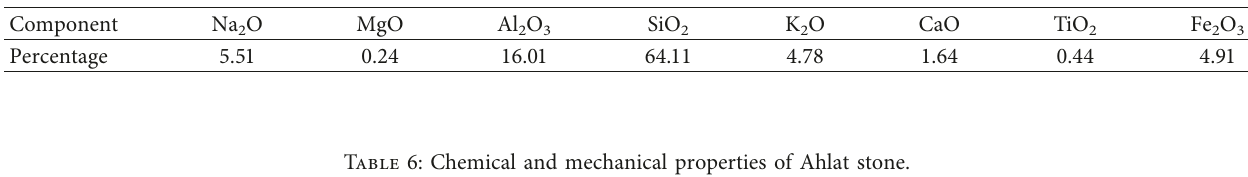
Figure 2: Ahlat stone powder used for ASWC and ASCC production. Table 5: Chemical properties of Ahlat stone.